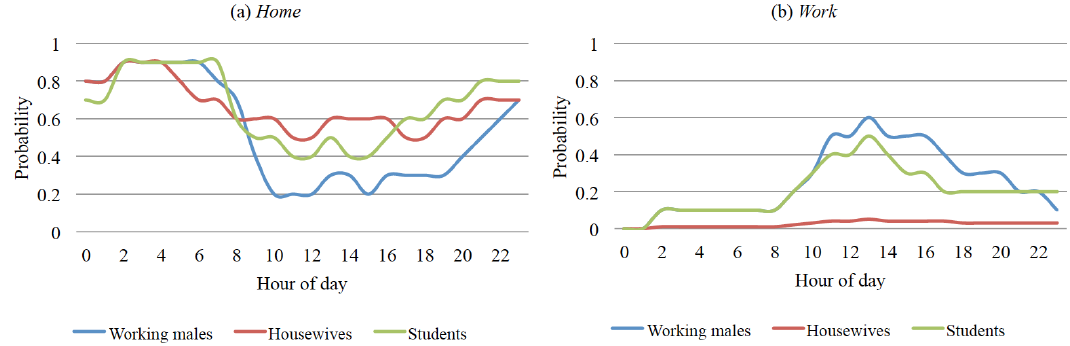
Figure 4. Hourly probability distribution of being at ( a ) home and ( b ) work for the three principal population groups. population